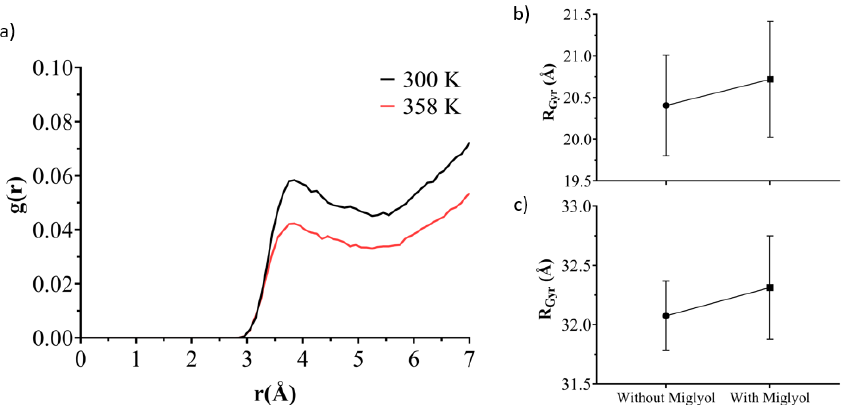
Figure 9. ( a ) Average radial pair distribution functions (RDF) for oxygen from the water against Lauric acid PEG tail at 300 K (black line) and 358 K (red line). The radius of gyration of ( b ) Mono-, Di- and Tri-glyceride Lauric acid (hydrophobic core) and ( c ) Lauric acid PEG (amphiphilic surface), in the presence and absence of Miglyol ® 812 at 358 K.